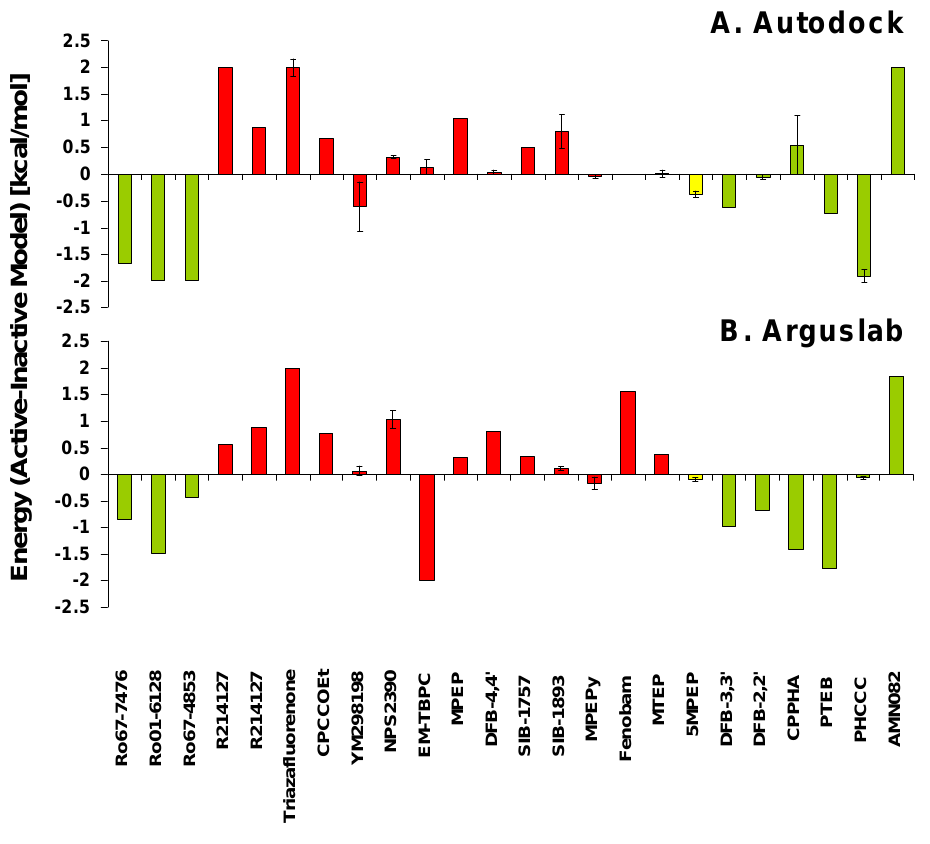
Figure 4. Differences in energy between active (Anisotropic Network Model based) and inactive (rhodopsin crystal-structure based) models of mGluRs. Green bars indicate positive modulators, red bars negative modulators and the yellow bar represents a neutral ligand. Where values of 2 are shown, the ligand did not dock to the active model, where values of − 2 are shown, the ligand did not dock to the inactive model. Error bars indicate standard deviation in three docking experiments each for the respective active and inactive models. If an error bar is placed at a − 2 or 2 bar, the error represents the standard deviation of the ligand and model combination where docking was observed. A. Results from docking with Autodock software. B. Results from docking with ArgusLab software. Image is adapted from